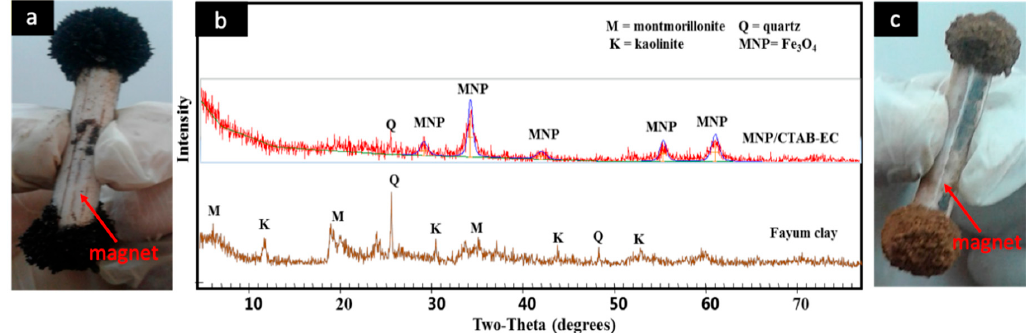
Figure 1. Photograph of magnetic nanoparticles ( a ), X–ray diffraction of the initial Fayum clay and the final composite MNP/CTAB-EC ( b ), and photograph of the final magnetic composite MNP/CTAB-EC ( c ).